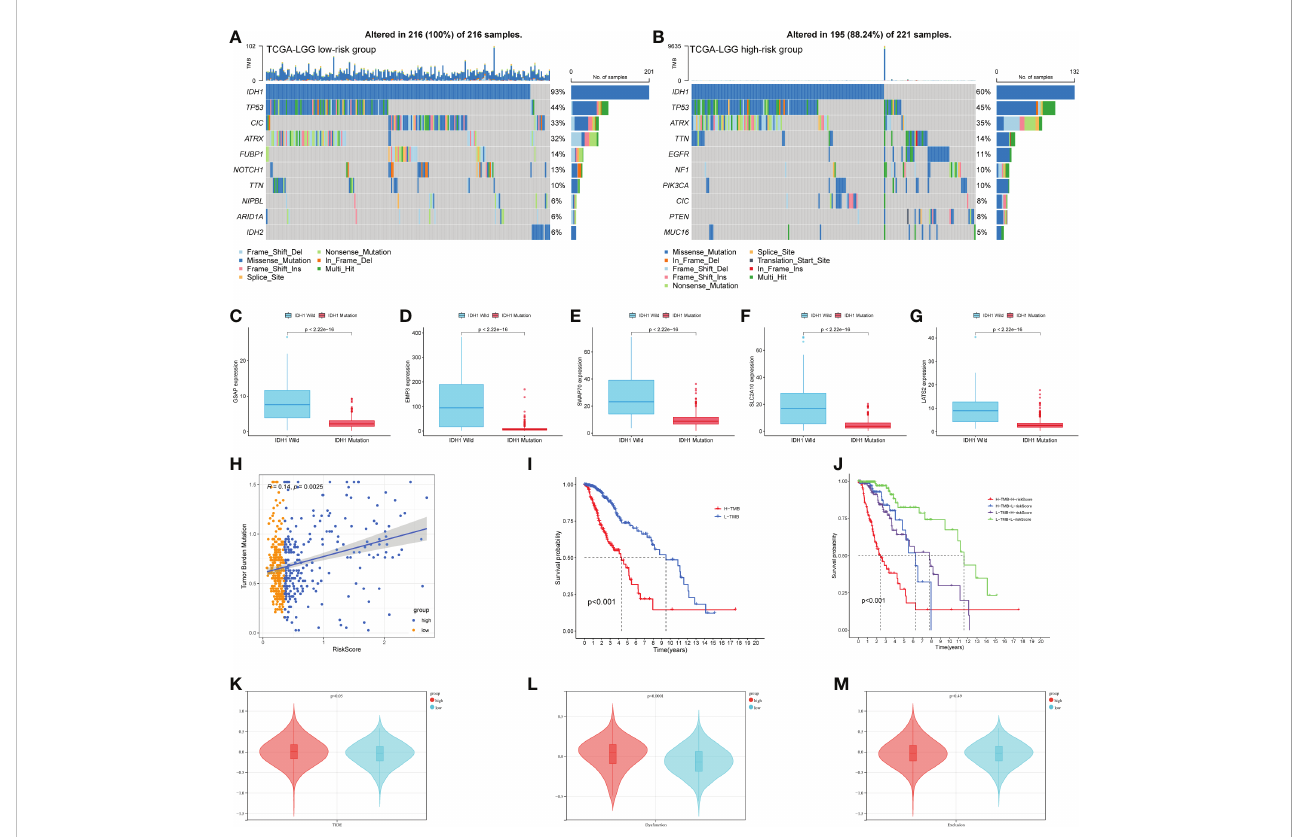
FIGURE 8 Epigenetic analysis of risk genes. (A, B) The mutation of high- and low-risk groups (Top 10 mutated genes). (C – G) Expression of 5 risk genes in the presence of different IDH1 mutations status. (H) Correlation analysis of risk score and TMB. (I) K-M curves of the high-TMB and low-TMB groups (p< 0.001) . (J) The combined risk score and TMB analysis of K-M curves in LGGs patients. (K – M) TIDE algorithm to model tumor immune evasion, (K) TIDE score, (L) Dysfunction score, and (M) Exclusion